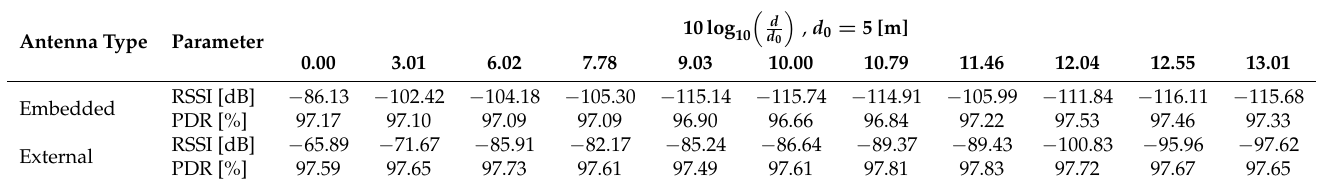
Table 3. Measured average of received power and Packet Delivery Ratio for Line-of-Sight scenario.